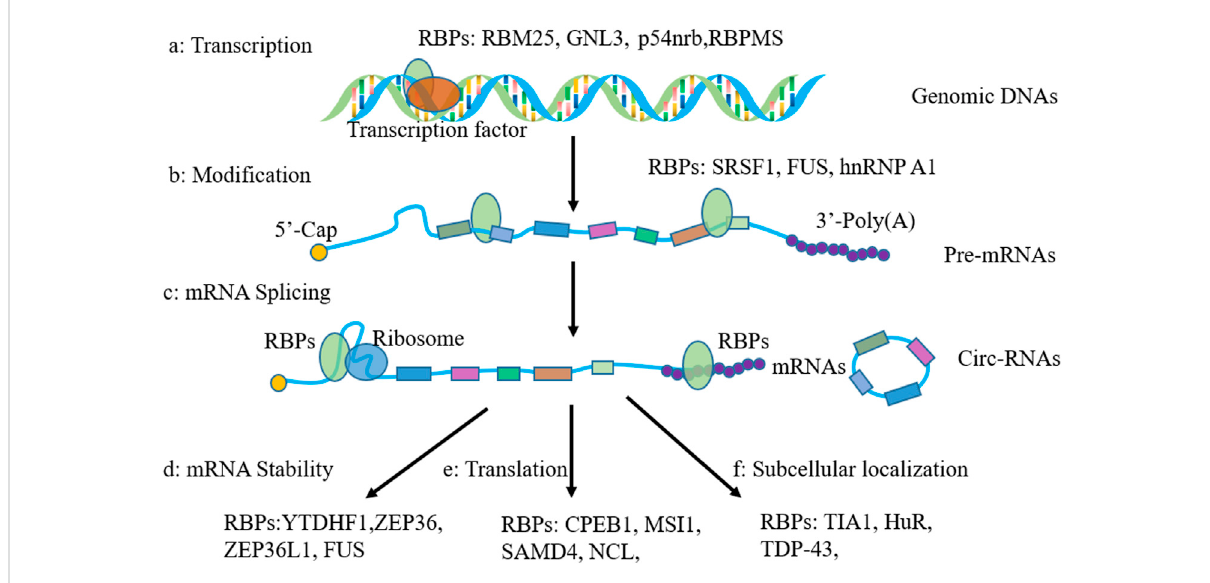
FIGURE 1 Functions of RNA-binding proteins in regulating gene expression. (A) regulation in gene transcription; (B) mRNA modi fi cations; (C) function in RNA splicing; (D) Function in regulating RNA stability; (E) regulation of gene translation; (F) regulation of mRNA subcellular